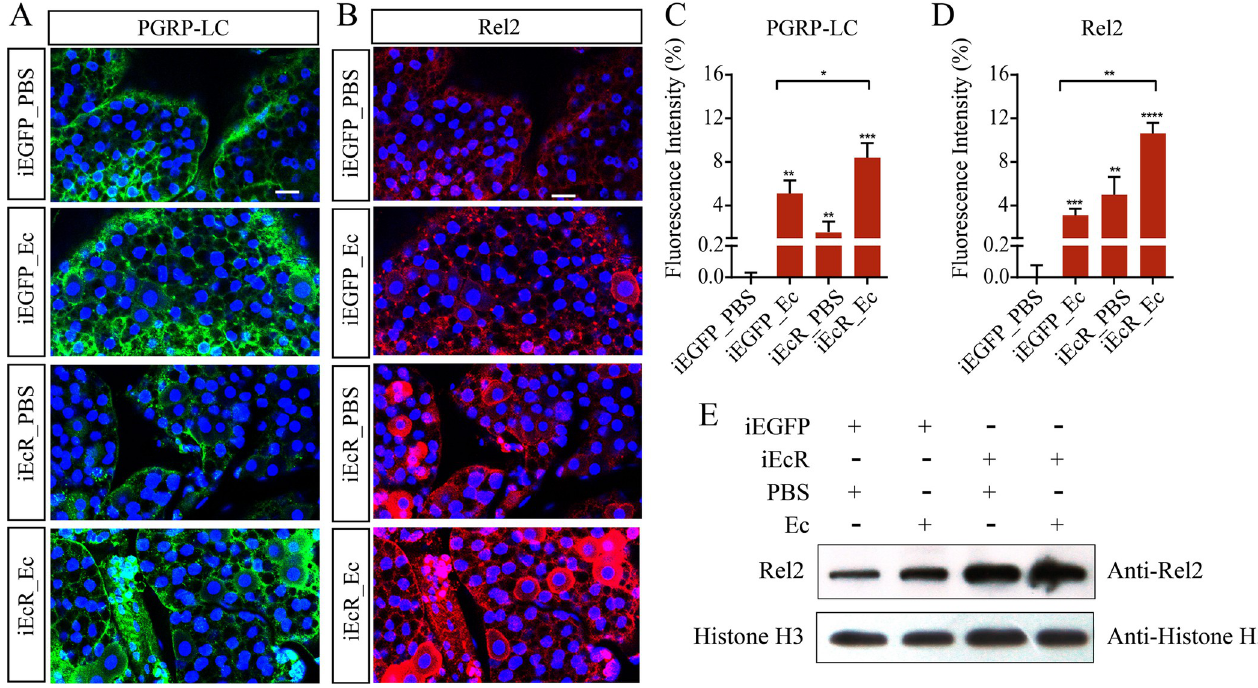
Fig 1. RNAi silencing of EcR results in elevated activation of PGRP-LC and Rel2 in response to bacterial infection. (A and B) Immunofluorescence of PGRP-LC (A) and Rel2 (B) in iEGFP and iEcR mosquito fat bodies, stimulated for 12 h with PBS or E . cloacae 12 h after blood meal. Scale bar, 20 μ m. (C and D) Quantification of relative fluorescence intensity of cells stained using PGRP-LC or Rel2 antibodies. (E) Protein levels of Rel2 in the nucleus of iEGFP and iEcR mosquitoes that were either non-infected or infected with E . cloacae . For each group, nuclear protein extracts were performed from extracts of fat bodies from ten female mosquitoes after 24 h of E . cloacae challenge. Histone H3 were used as controls. Data are from three biological replicates.